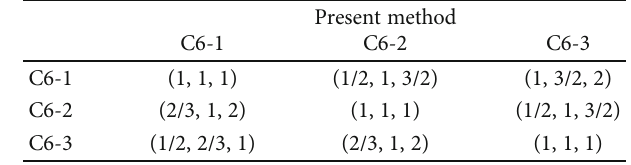
Table 8: The comparison matrix with respect to the water environmental quality.